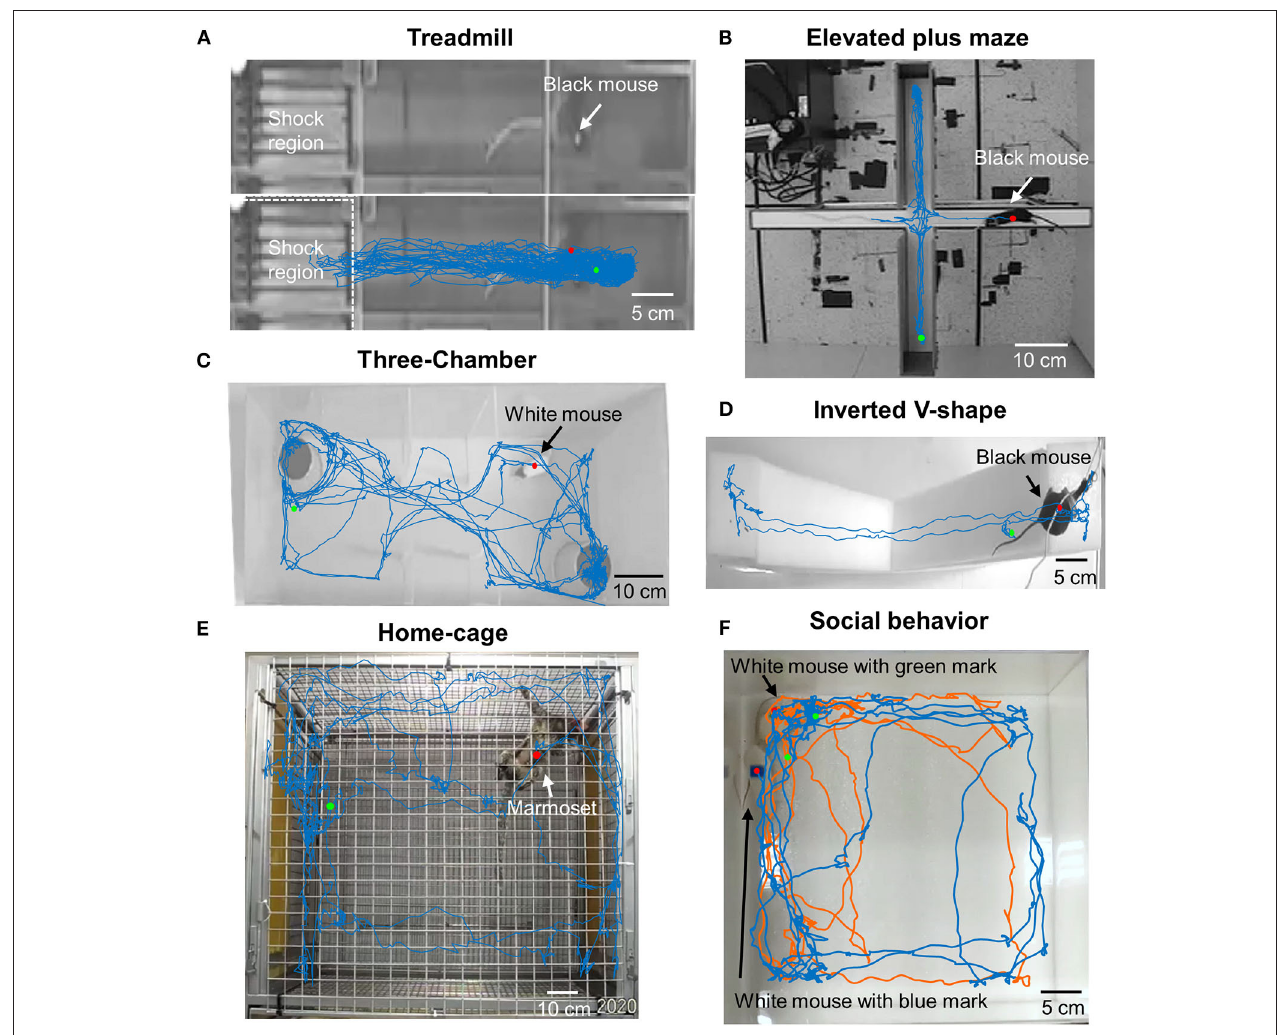
FIGURE 4 | Movement tracking in diverse paradigms using DeepBhvTracking. (A) Black mice in treadmill task. With a black mouse on a black background, the ratio between signal and noise is very low. Moreover, the animal only runs in a restricted area because it has been trained not to fall behind the treadmill. It is very difficult to calculate the speed of the animal while performing neuronal decoding in this task. Our DeepBhvTracking method overcomes this challenge and achieves a smooth movement trace. (B) Black mice in elevated plus maze. (C) White mice in three-chambered box maze. (D) Black mice in inverted V-shape maze. (E) Marmoset movement trace in home cage. (F) Social behavior of white mice in open field. Blue trace: White mouse with a blue mark on its back. Orange trace: White mouse with a green mark on its